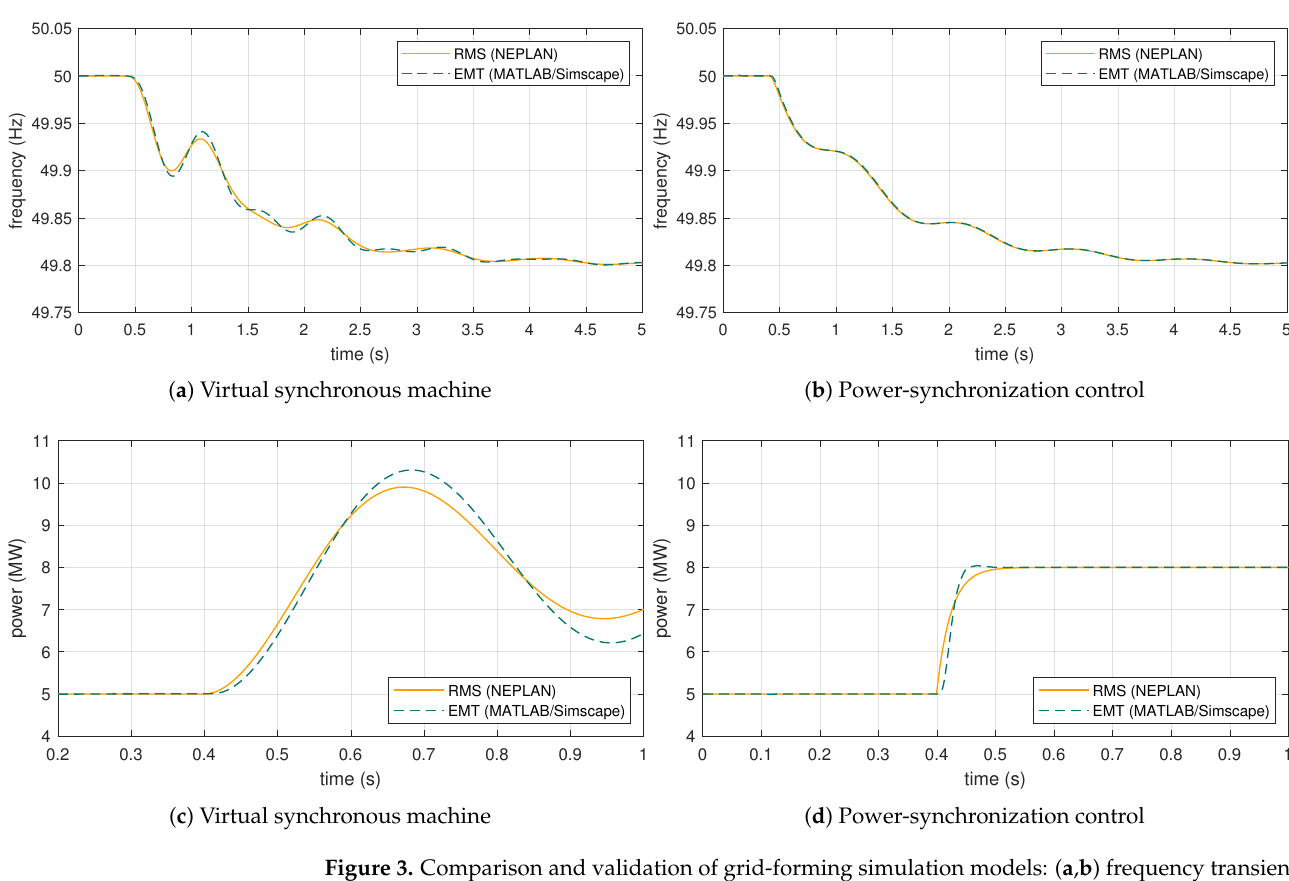
Figure 3. Comparison and validation of grid-forming simulation models: ( a , b ) frequency transients caused by the application of a power imbalance; ( c , d ) step in the active power reference of the grid-forming